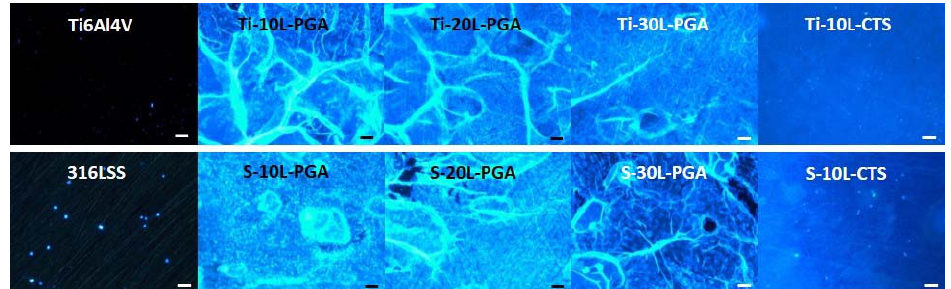
Figure 7. Fluorescence microscopy images of the MG63 cells seeded on different layers of C/PGA on Ti6Al4V and 316LSS substrates for three days and stained with Hoechst 33258. The scale bars are labeled in white or black with the length of 100 μ m.